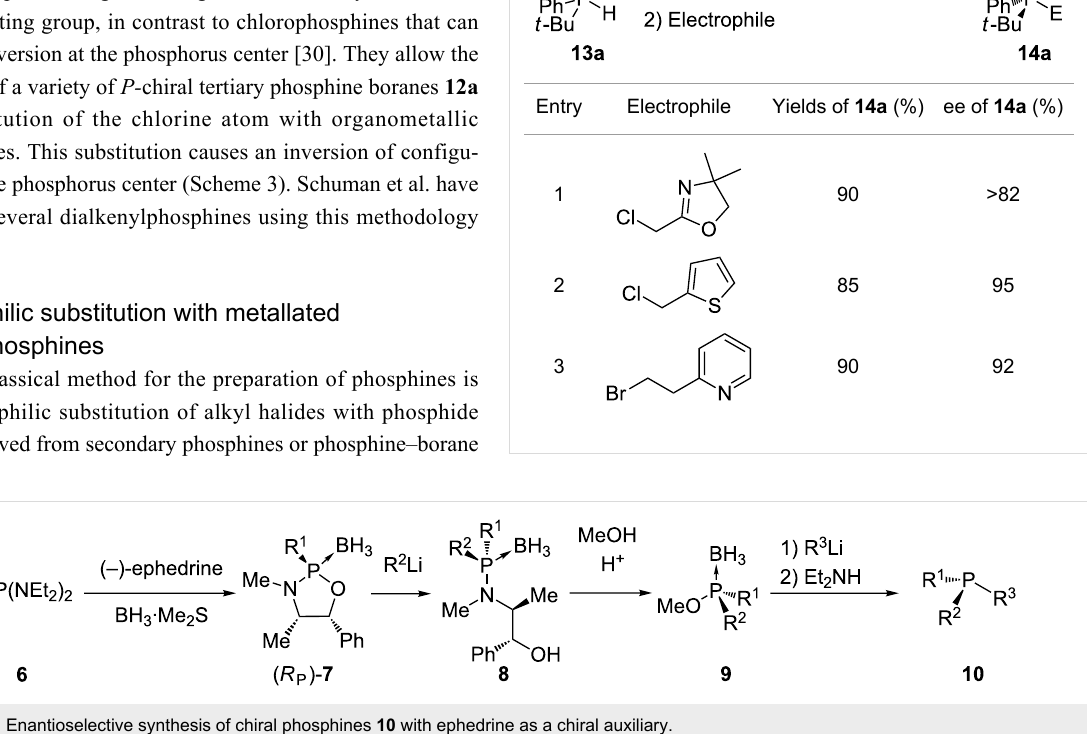
Entry Electrophile Yields of 14a (%) ee of 14a